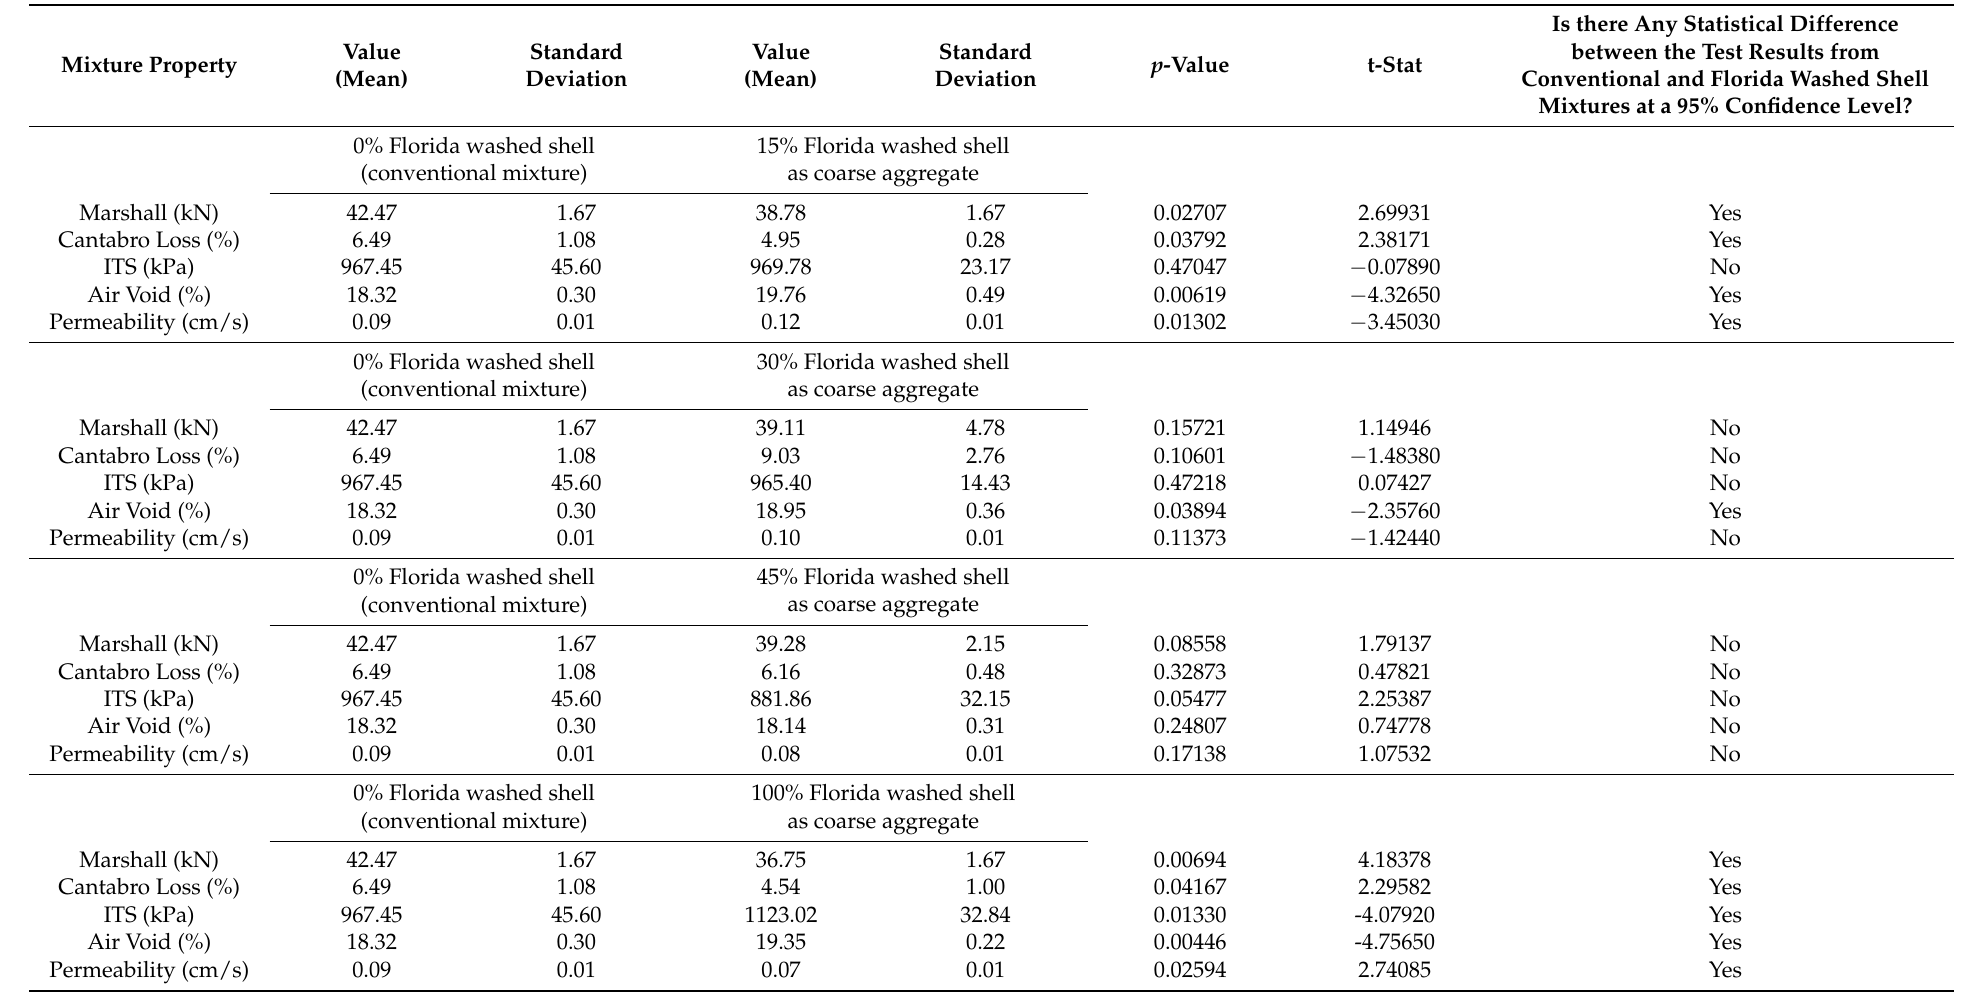
Table 6. Statistical analysis of laboratory test results from open-graded asphalt mixtures of 4.75 mm